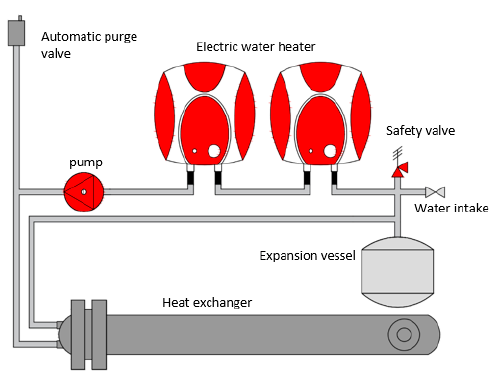
Figure6. Representationoftheconfigurationoftheheatingsystemdesignedforkeepingthetemperature Figure 6. Representation of the configuration of the heating system designed for keeping the of anaerobic temperature of anaerobic reactor.